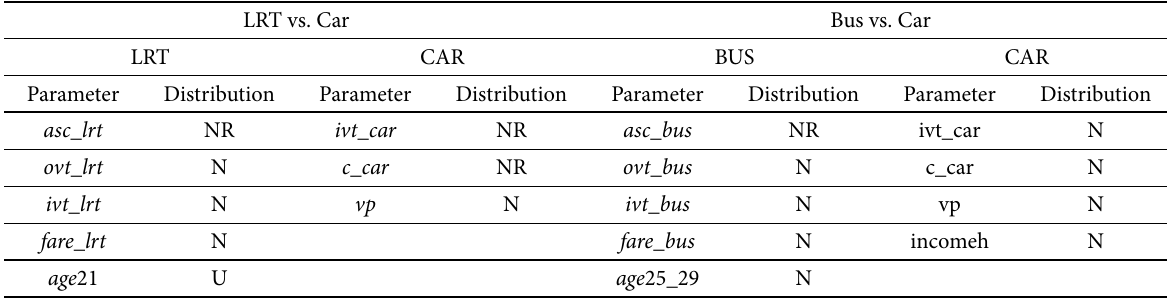
Table 5. Distribution of the parameters for LRT vs. Car and for Bus vs. Car (NR: Non-random; N: Normal; U: Uniform). LRT vs. Car Bus vs. Car LRT CAR BUS